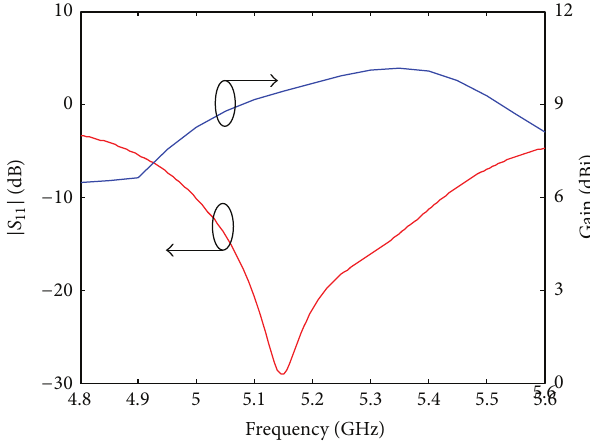
Figure 9: Geometry of the Yagi array of half-wave patch antennas.